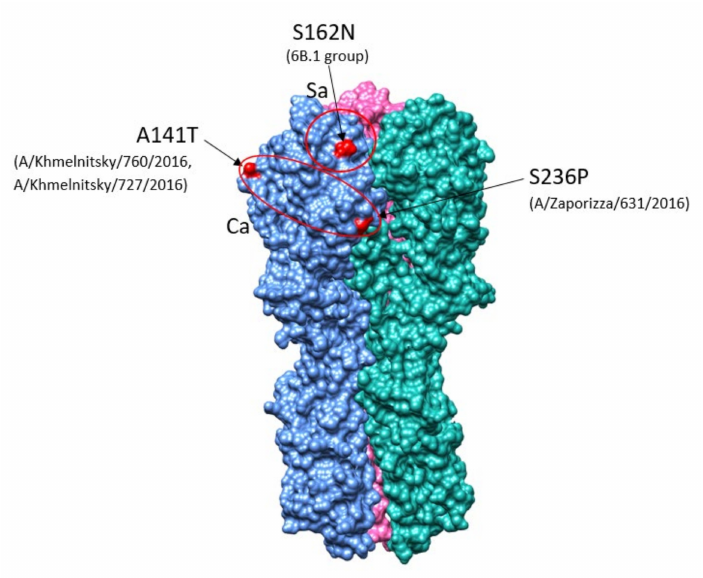
Figure 4. 3D structure of HA molecule with changes in antigenic sites of Ukrainian isolates (PDB